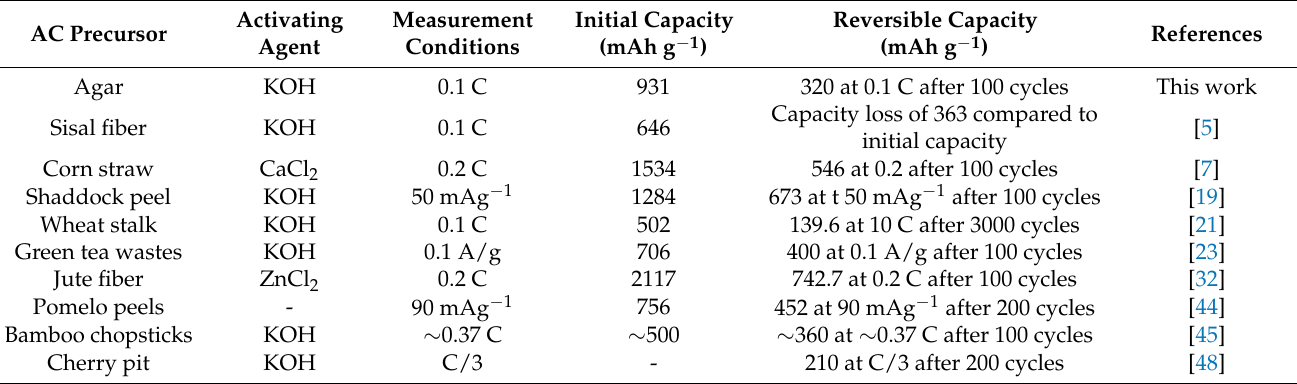
Table 1. Comparison of the electrochemical characteristics of different bio-derived ACs used as anode materials for lithium-ion batteries